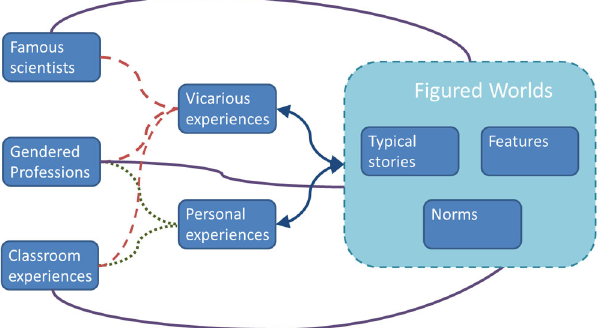
FIG. 1. Schematic of the relationship between the topical categories of discussion, types of experiences, and attributes of figured worlds. The topical categories of discussion are con- nected to types of experiences by two types of line: The dashed lines connect topical categories to vicarious experiences, and the dotted lines connect the topical categories to personal experi- ences. Additionally, solid lines connect topical categories directly to attributes of figured worlds. Types of experiences and attributes of figured worlds are connected by lines with double arrowheads in order to represent their reciprocal